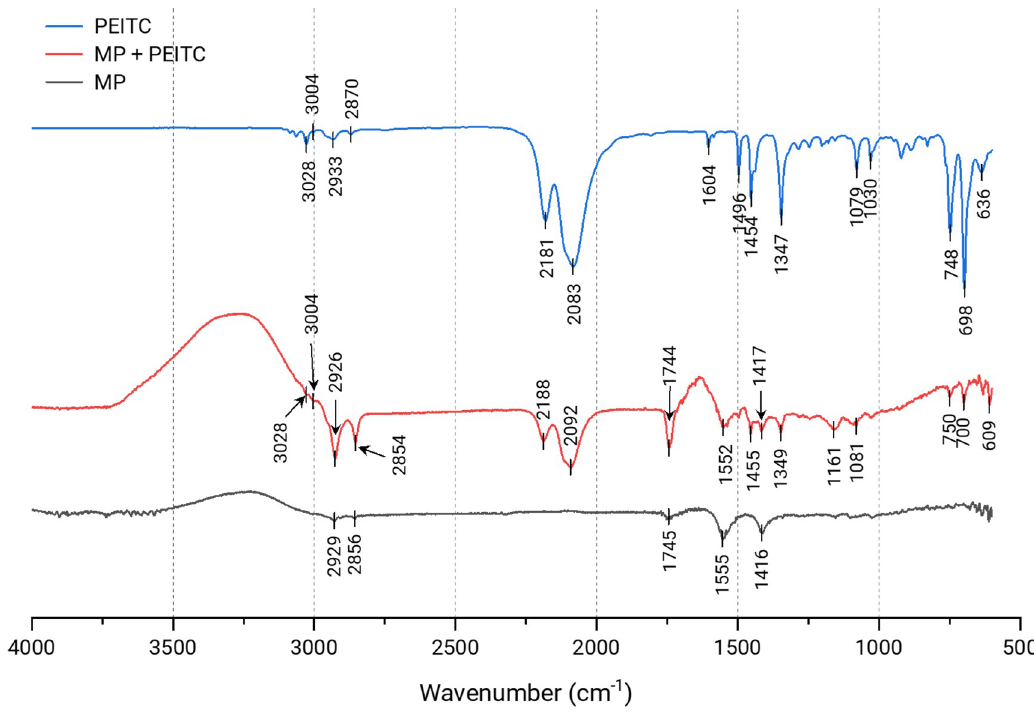
Fig 7. Fourier transform infrared transmittance spectra for empty MPs, MPs with PEITC (MP + PEITC) and pure PEITC. FTIR.